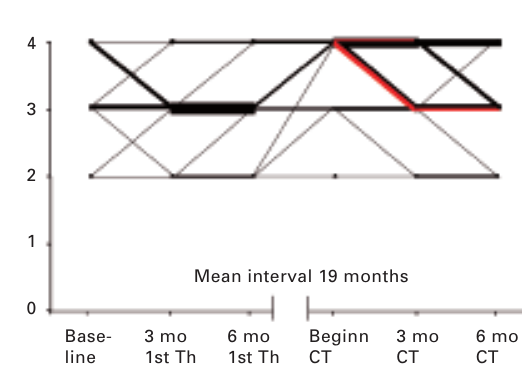
Change in Borg Scale ratings. CT = combi- nation therapy, mo = months, th = therapy. Every line shows the course of a single patient. Black lines are used for patients with initial monother- apy, red lines for patients with CT from the beginning. Patients with IPAH are represented by plain lines, patients CTEPH by dotted lines and patients with PH associated with collagen vascu- lar disease by dashed lines.